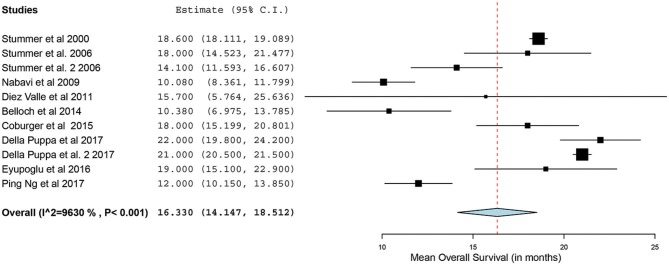
Forest plot graph representing the meta-analysis of mean overall survival (95% confidence interval [CI]) among patients with primary high-grade gliomas treated using 5-aminolevulinic acid–guided surgical resection. Used with permission from Barrow Neurological Institute, Phoenix, Arizona.